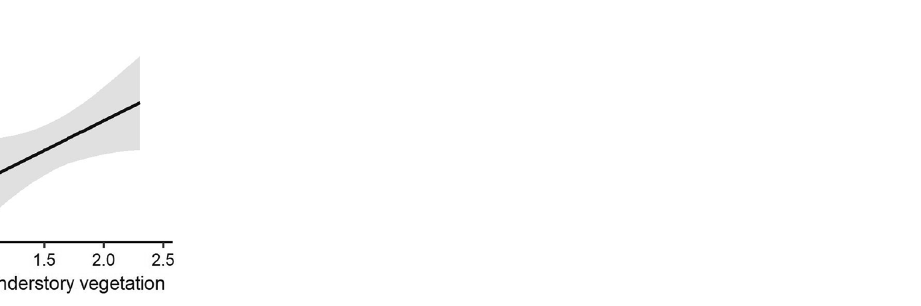
Figure 4. Cover effects on the home range of red-backed voles ( Myodes regulus ) determined by the linear model.